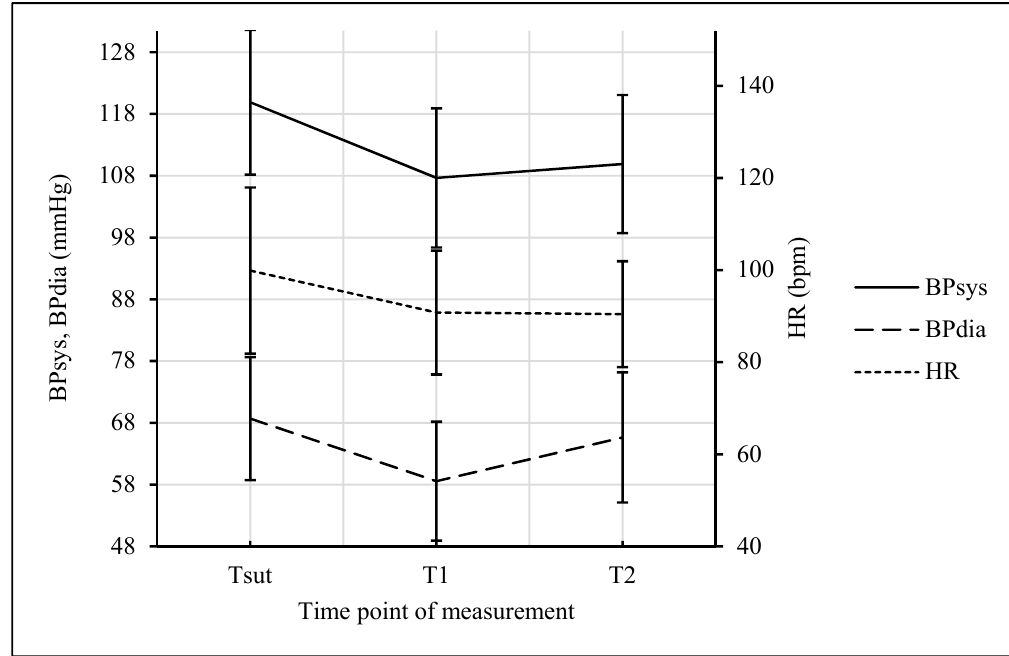
Figure 2. Systolic (BPsys), diastolic blood pressure (BPdia), and maternal heart rate (HR) at skin suture (T sut ), 2 h (T1), and 24 h (T2) after the intervention, respectively. Data presented as mean values (SD) (T sut to T1 all p < 0.001).